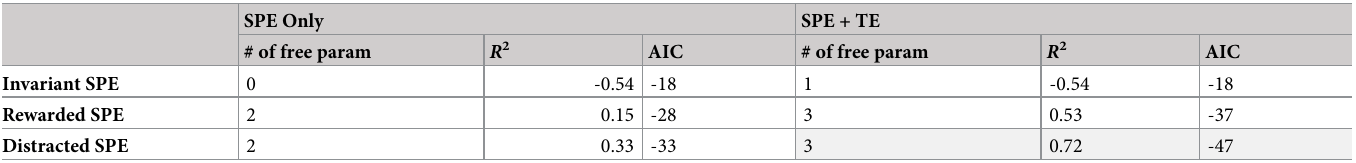
Table 4. Summary of model-based